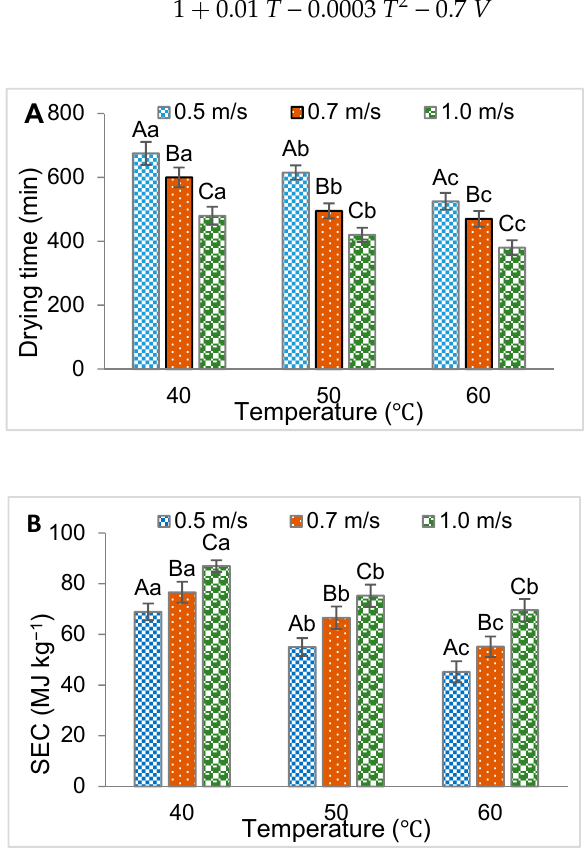
Figure 2. The impact of air velocity and temperature on drying time ( A ) and specific energy consumption (SEC, B ) using a hot air convection dryer. The di ff erent capital letters at the same temperature showed significant di ff erences, while di ff erent lowercase letters of the same series showed significant di ff erences (at P ≤ 0.05). The equation 5 model was found to fit the experimental data with an adjusted determination coe ffi cient (Adj R 2 ) of 0.987, correlation coe ffi cient (R 2 ) of 0.998 and the fit standard error (Fit Std Err) of 5.68, indicating that the fitness of the selected model is